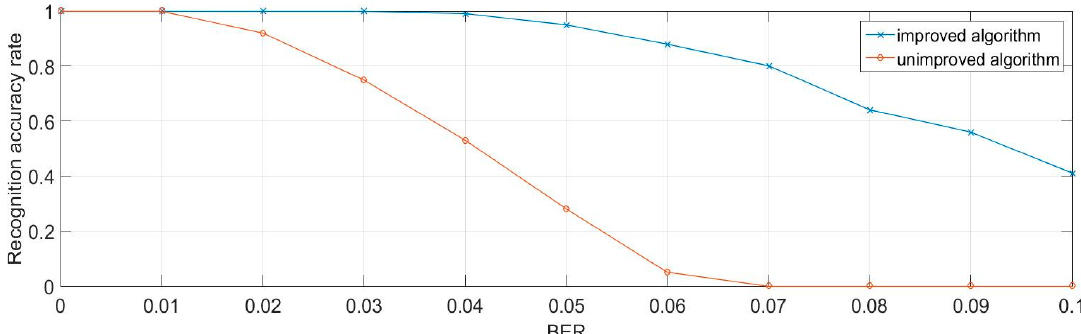
Figure 5. Comparation of the improved and unimproved algorithm. Obviously, the improved algorithm performs better under high BER circumstances.